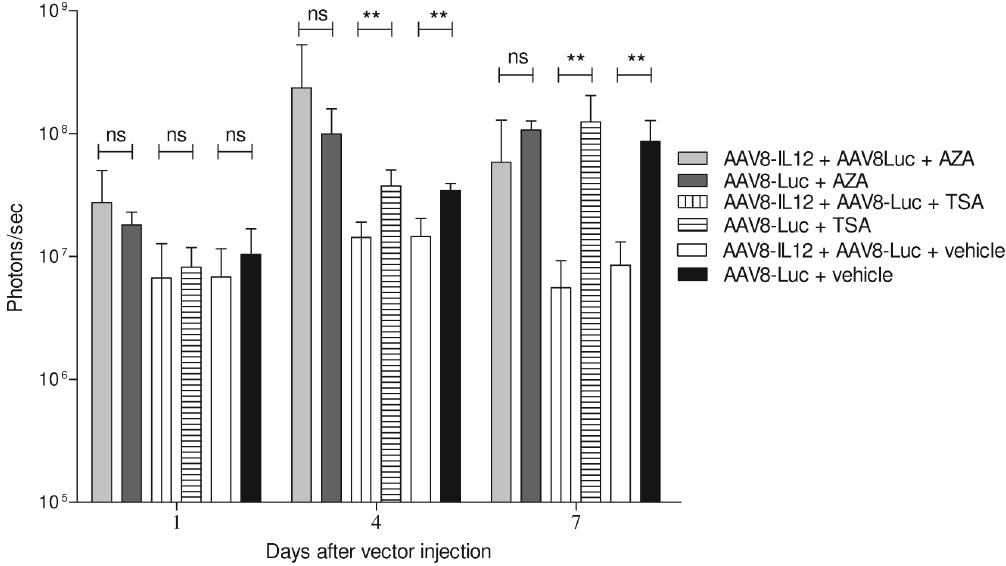
Figure 4. DNA demethylating agents but not histone acetylation inhibition revert the IFN- c inhibitory effect. C57BL/6 mice received 2.5 6 1011 vg/kg of AAV8-luc vector alone or in combination with 1.5 6 109 vg/kg of AAV8-IL12 vector. One group of 5 mice treated with AAV8-luc or AAV8-luc in combination with AAV8-IL12 received 5 9 -Azacytidine (AZA) intraperitoneally at a dose of 1 mg/kg every 24 hours starting the day of vector injection. A second group of 5 mice treated with AAV8-luc or AAV8-luc in combination with AAV8-IL12 received 2 mg/kg of trichostatin A (TSA) were injected IP every 48 hours starting the day of vector injection. A third group of animals received only vector injection. Luciferase expression levels were analyzed in both groups of animals at days 1, 4, and 7 using a Xenogen in vivo luminometer, experiments could not be performed at longer time points due to the toxicity of 5-AZA long term treatment. Luciferase expression was quantified and represented as photons/ second. The data are shown as mean 6 standard deviation (SD). The differences in luciferase expression were statistically evaluated by Student t test (**p , 0.01).